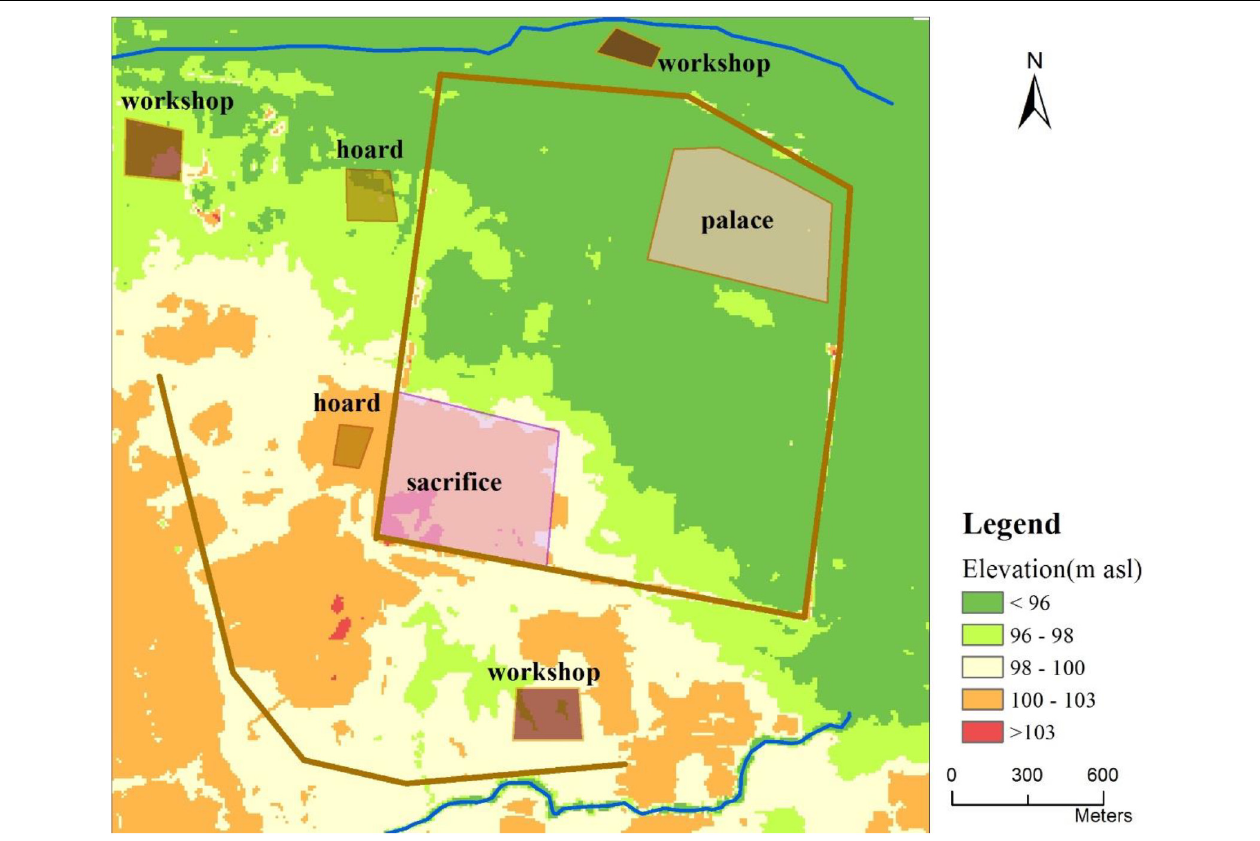
FIGURE 6 | The relationship between the topography and layout of Zhengzhou Shang City. The inner city was located in the flatter terrain. The palace, hoards and sacrifice area were arranged in the higher region. The workshops were close to the rivers.